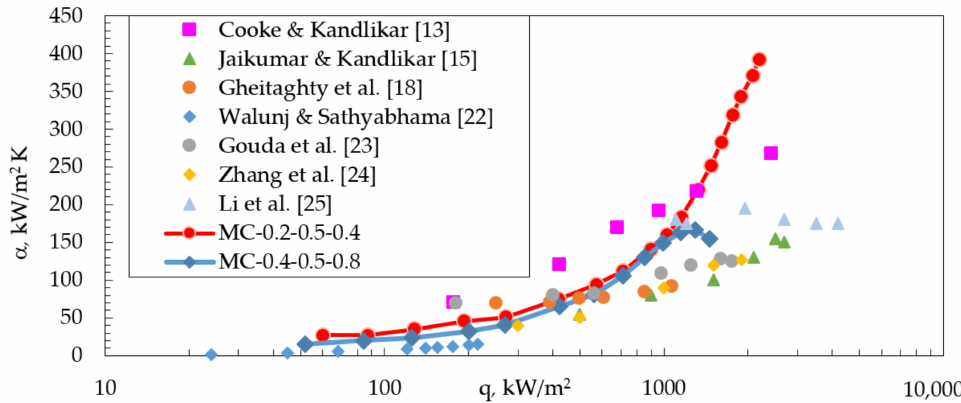
Figure 9. Pool boiling performance comparison with different structures reported in the literature with water as the working fluid [13,15,18,22–25].